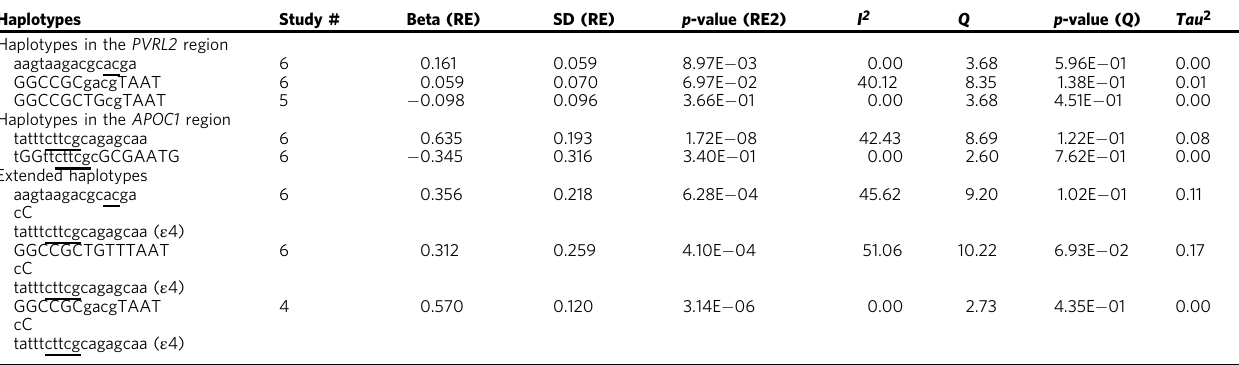
Table 2 Meta-analysis of AD-associated haplotypes after controlling for APOE genotypes